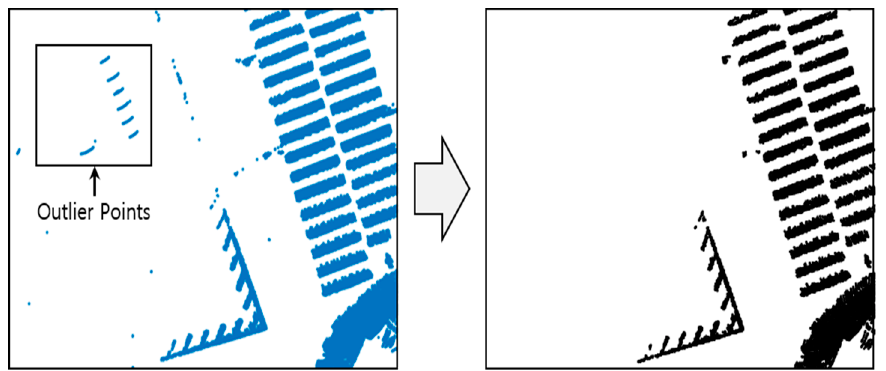
Figure 12. Result of outlier removal using the occupancy grid filter.